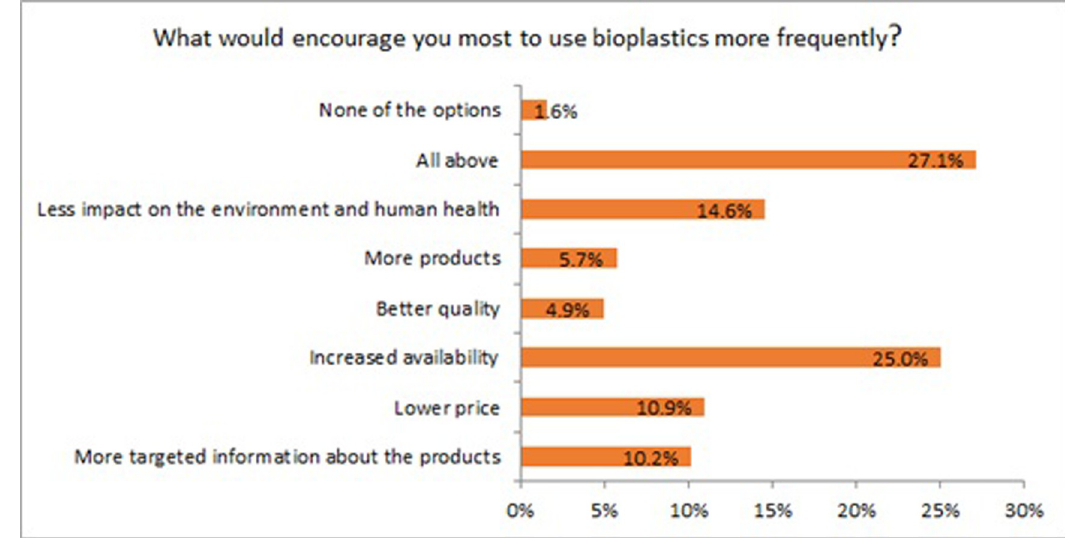
Fig 7. Main drivers encouraging the use of bioplastics more frequently (n = 384).